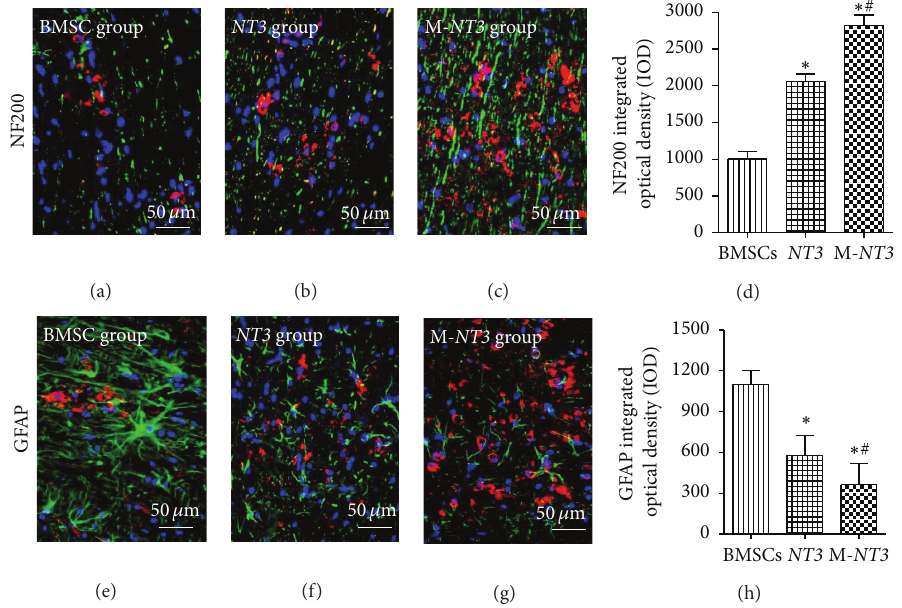
Figure 8: Immunofluorescence labeling of NF200 ((a), (b), and (c)) and GFAP ((e), (f), and (g)) in sagittal sections of the injured spinal cords from each group on day 35 after cell transplantation. Double labeling for NF200/GFAP (green) and BMSCs (red). Magnification, × 400 ((a)–(c), (e)–(g)). Scale bar, 50 𝜇 m ((a)–(c), (e)–(g)). Integrated optical density (IOD) bar graphs showing NF200 (g) and GFAP (h) expression in each group. All microscopic images were captured under identical conditions. The data, which are presented as the means ± SD ( 𝑛 = 12 ), were analyzed using one-way ANOVA. ∗ 𝑝 < 0.05 versus the BMSC group, # 𝑝 < 0.05 versus the NT3